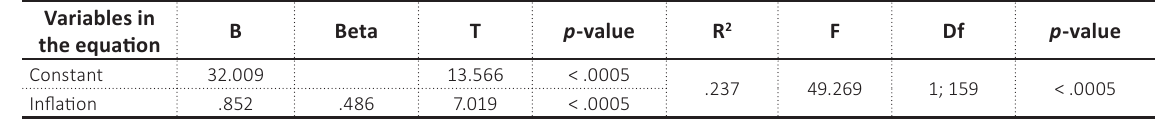
Table 9. Influence of inflation on organizational decisions